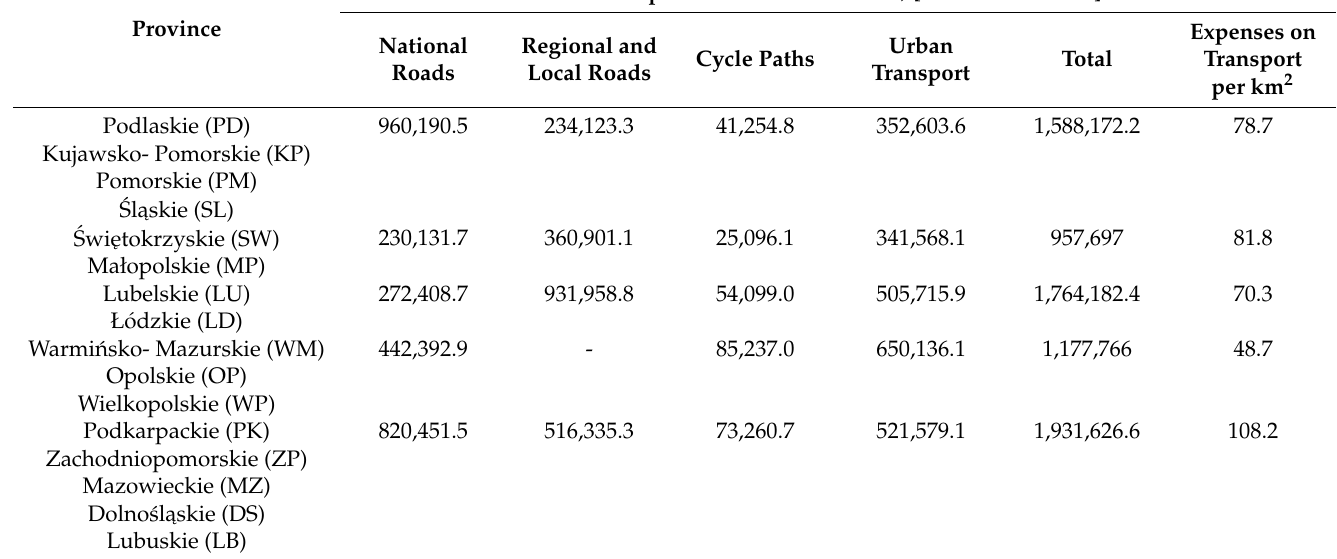
Table 2. Expenditures on transport development in provinces from the Operational Program for Development of Eastern Poland implemented in the financial perspective 2007–2013. Source: the